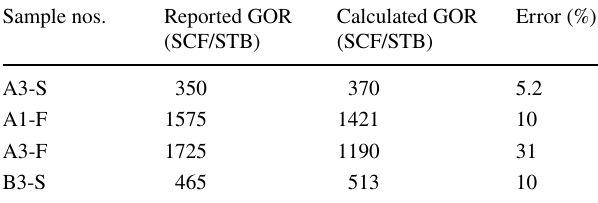
Table 3 Observed material balance problems Sample nos.